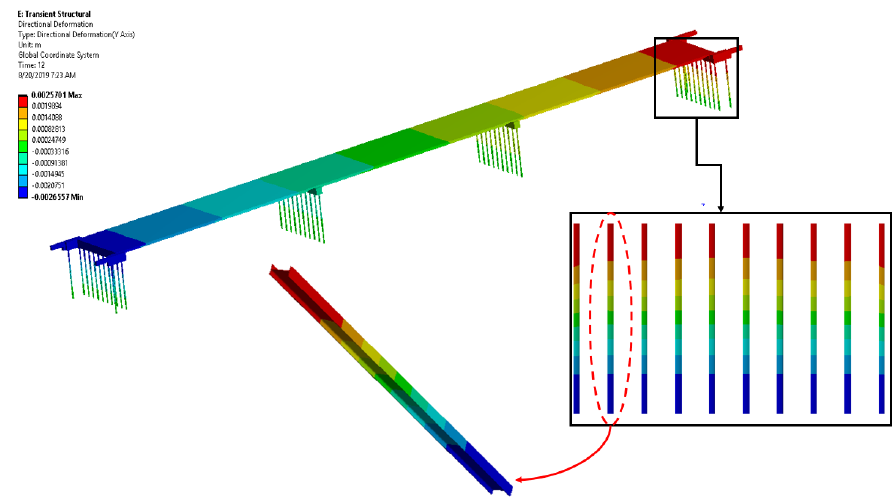
Figure 9. Longitudinal deformation contour of the deck in the integrated concrete bridge with steel piles due to the mean values of monthly temperature changes (large variations).